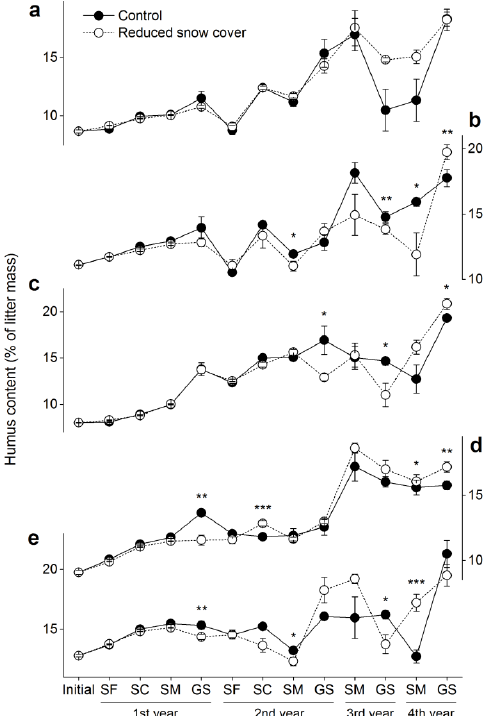
Figure 2. Humus contents (±SE, n = 6) in the five foliar litters. ( a ) Cypress, ( b ) larch, ( c ) birch, ( d ) willow and ( e ) azalea. SF: snow formation stage, SC: snow cover stage, SM: snowmelt stage, GS: growing season. * p < 0.05, ** p < 0.01, *** p < 0.001.